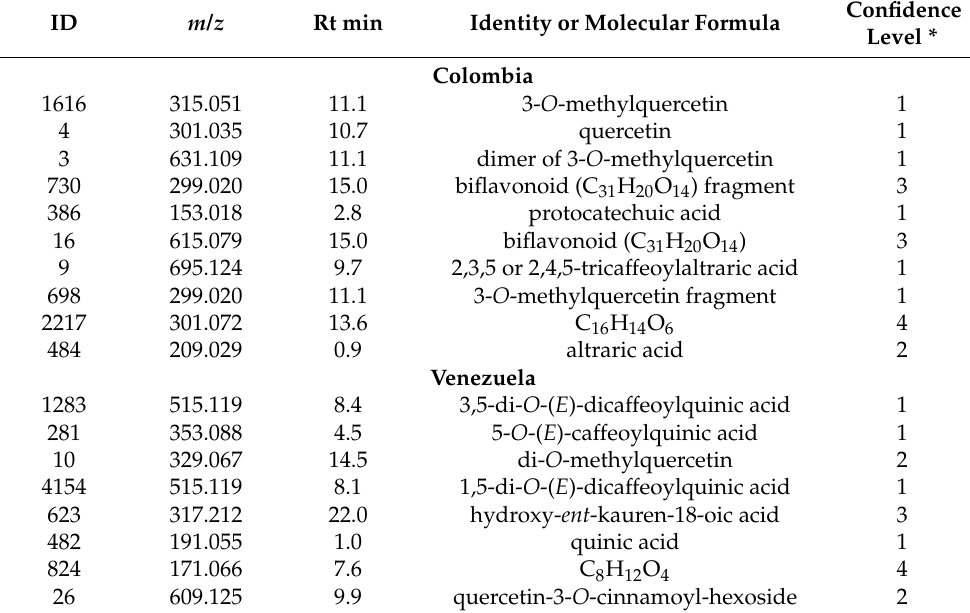
Table 1. Discriminant metabolites of the country of origin of 113 taxa of Espeletiinae selected based on the analysis of the PCA loadings plot (Figure 2b). Metabolites sorted by their added contribution in the first two principal components. See Supplementary Information for compounds annotation. ID m/z Rt min Identity or Molecular Formula